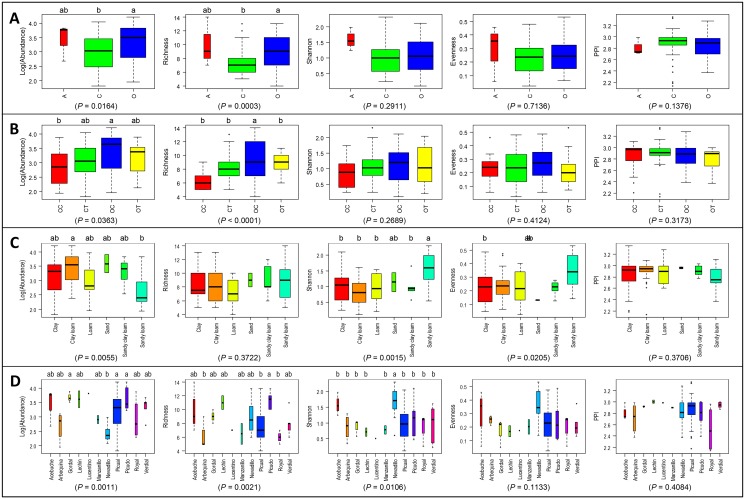
Summary box-plots of nematode abundance, Richness, Shannon, and Evenness diversity indexes and Plant Parasitic Index (PPI) derived from results of nematode identification in 92 olive orchards (S1 Table) grouped by the agronomic characteristics of the olive orchards sampled.(A) Orchard management systems included: A = Wild olives or ‘Acebuches’, O = Organic management; C = Conventional management. (B) Soil management systems included: CC = Conventional management with cover crop, CT = Conventional management with tillage, OC = Organic management with cover crop, and OT = Organic management with tillage. (C) Soil texture. (D) Olive cultivar. The rank-based Kruskall-Wallis test was used to determine differences in all estimated diversity indexes in relation to the different agronomic factors and the resulting probability values are shown. For each agronomic parameter and diversity index, boxes with a different letter indicate significant differences (P < 0.05) according to multiple pairwise comparisons between OMS, SMS, soil texture and olive cultivar levels determined by the Dunn test. (*) ‘Lucentino’ was present in only one orchard and was not included in the statistical analyses.